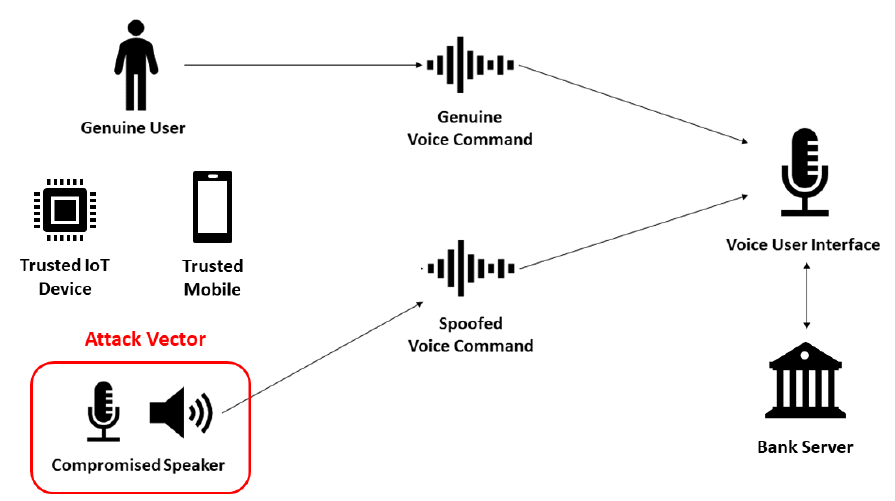
Figure 5. Threat model with the compromised speaker as the attack